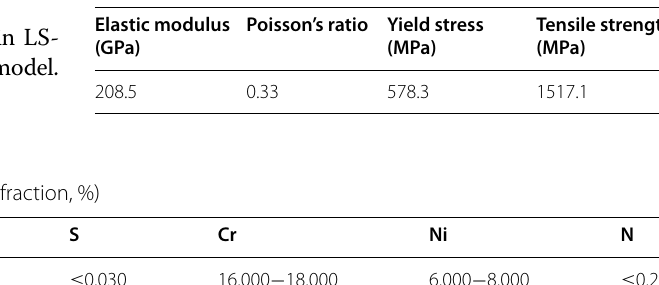
Table 2 The basic mechanical properties of